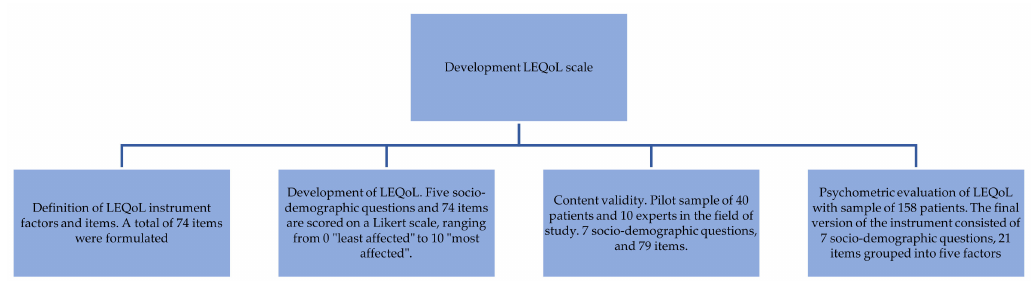
Figure 1. Quality of Life of Patients with Lupus Erythematosus Instrument (LEQoL) instrument development